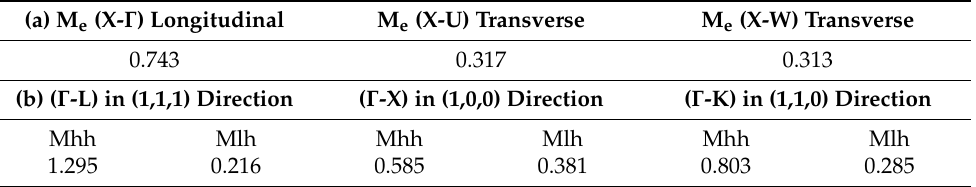
Table 4. Calculated electron (M e ) and hole effective masses for zb-BeS, in the indicated directions, in ( a ) for M e and ( b ) for heavy hole (M hh ) and light hole (M lh ) effective masses. The effective mass are in units of the free electron mass (m 0 ).